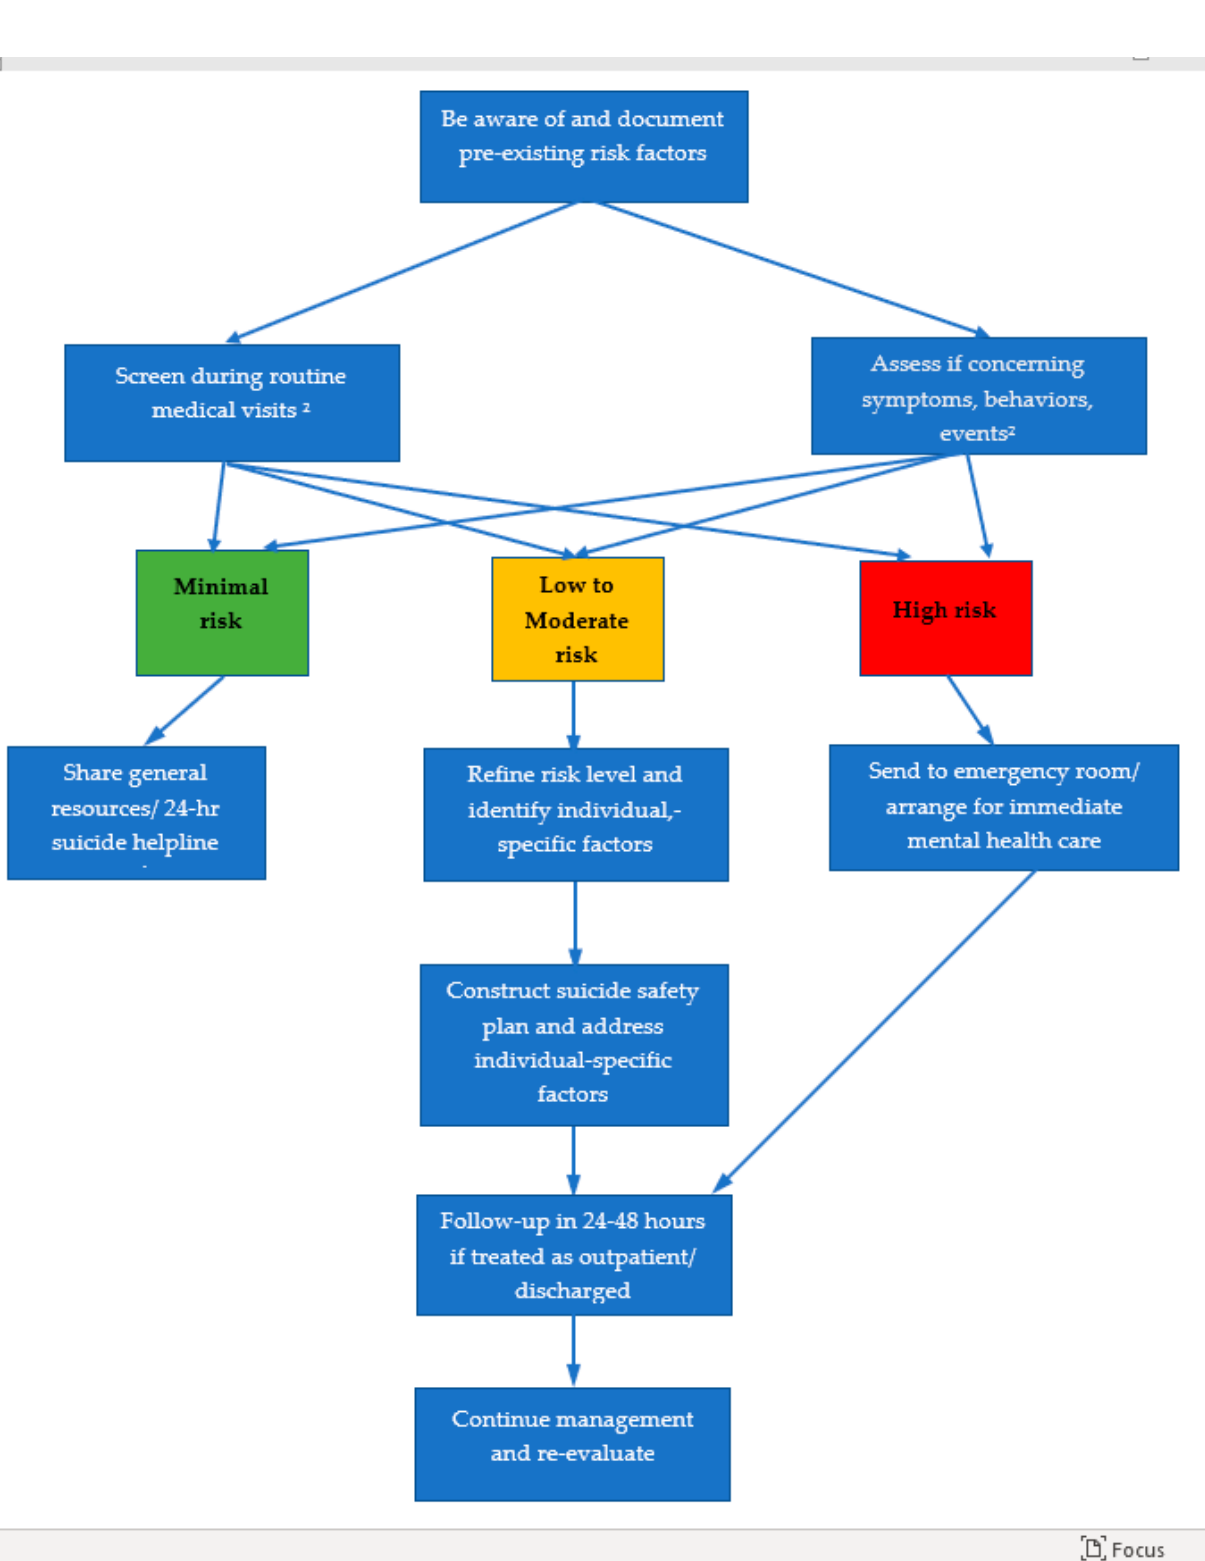
Figure 1. Overall approach to evaluation and management of suicidality in individuals. Use the Ask Suicide-Screening Questionnaire (ASQ) or Columbia—Suicide Severity Risk Scale (C-SSRS) for screening and assessment. See instruments for definitions of initial risk level and text for details.